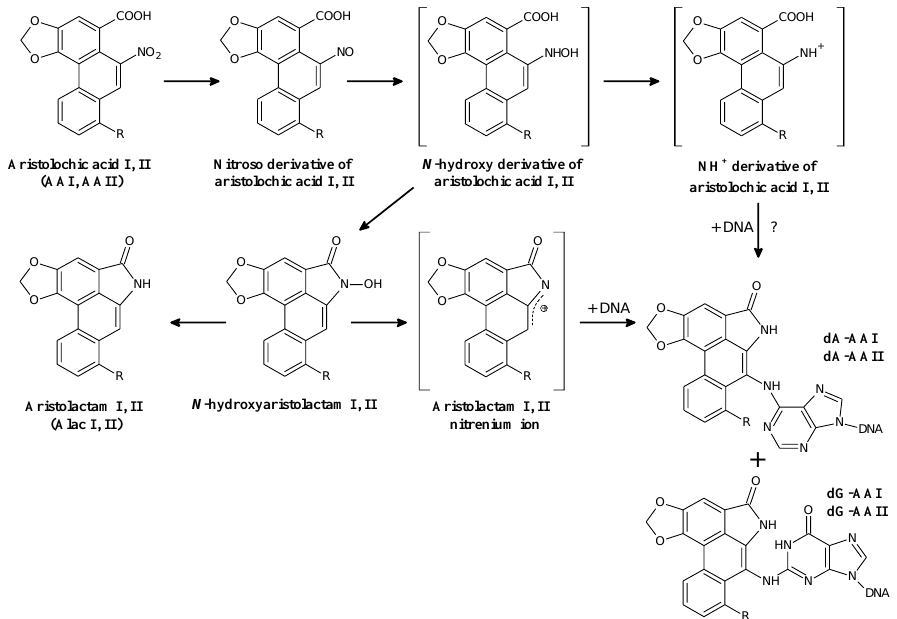
DNAO NNO Figure 2. Reductive activation of aristolochic acid I Figure 2. Reductive activation of aristolochic acid I [8-methoxy-6-nitro-phenanthro-(3,4- d )-1,3-dioxolo- [8-methoxy-6-nitro-phenanthro-(3,4- d )-1,3-dioxolo-5-carboxylic acid, AAI; R = OCH 3 ] and II 5-carboxylic acid, AAI; R = OCH 3 ] and II [6-nitro-phenanthro-(3,4- d )-1,3-dioxolo-5-carboxylic acid, [6-nitro-phenanthro-(3,4- d )-1,3-dioxolo-5-carboxylic acid, AAII; R = H] leading to formation of DNA AAII; R = H] leading to formation of DNA adducts. 7-(deoxyadenosin- N 6 -yl)aristolactam I or adducts. 7-(deoxyadenosin- N 6 -yl)aristolactam II (dA-AAI or dA-AAII), 7-(deoxyguanosin- N 2 -yl)aristolactam I or II (dG-AAI or dG-AAII). ?, 7-(deoxyguanosin- N 2 -yl)aristolactam I or II (dG-AAI or dG-AAII). ?, possible pathway. possible